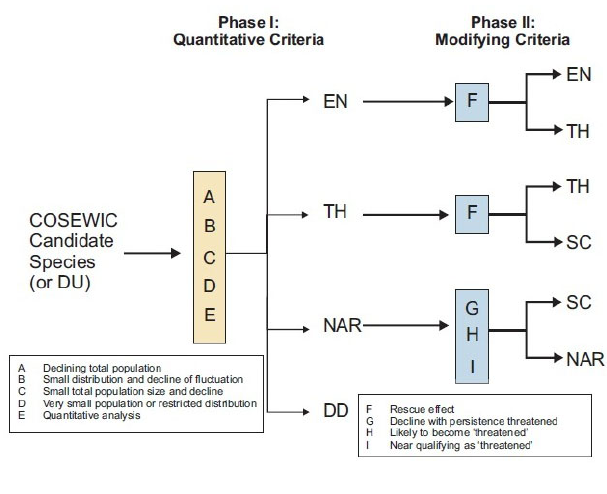
Fig. 1 . Summary of Committee on the Status of Endangered Wildlife in Canada (COSEWIC) quantitative and modifying criteria (Based on Lukey and Crawford 2009:960, used with permission). See Appendix 1 for glossary of acronyms.